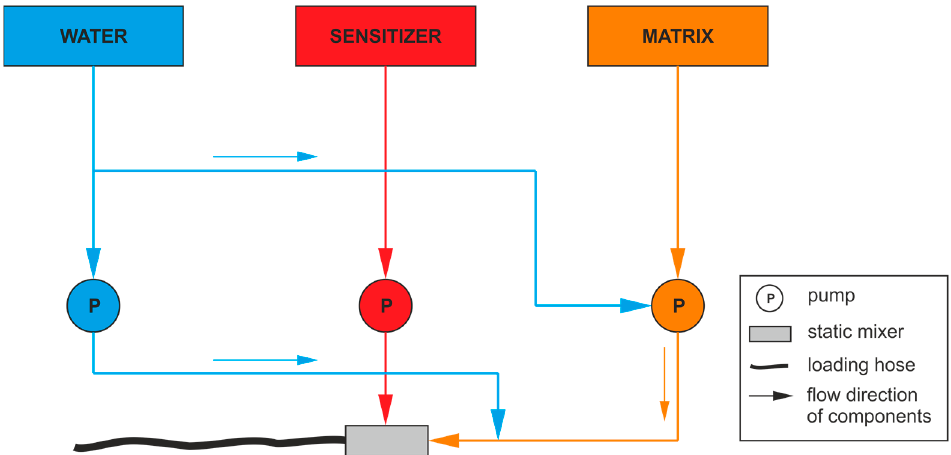
Figure 3. Simplified scheme of the mixing–charging units for bulk emulsions. Arrows indicate flow direction of the components.